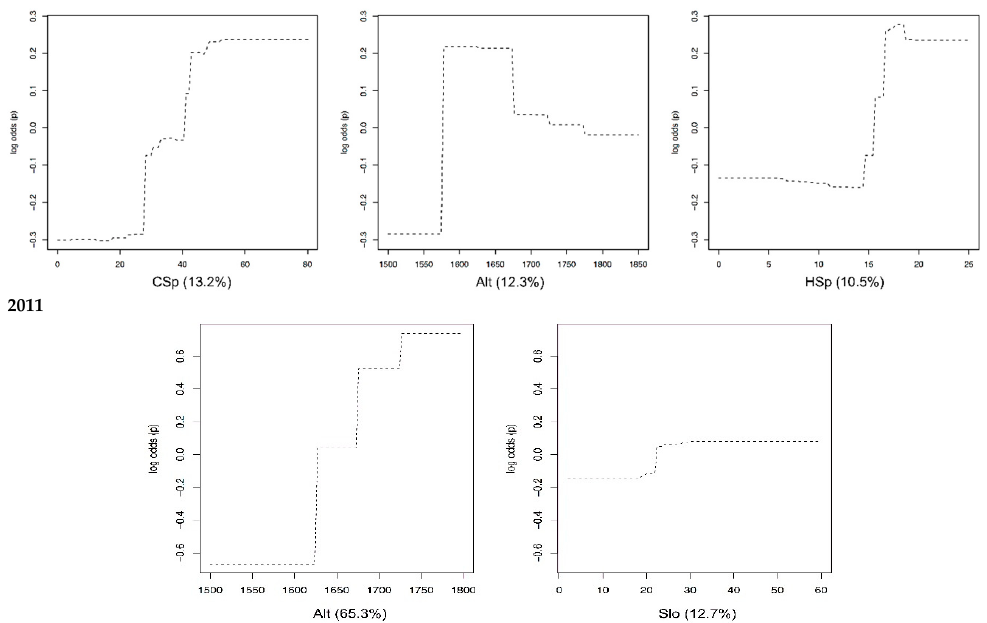
Figure 5. Relationship of the most influential variables (relative influence ≥ 10%) with capercaillie summer occurrence in 2001 and 2011, obtained by integrating out all other variables in a generalized boosted regression model. A logistic regression was used, and y-axes report the fitted values on log- odds scale (explanatory variables, with their codes, are reported in Table 2). Factors related to spruce were important for the presence of capercaillie. In 2001, capercaillie preferred forests where this tree species proportion exceeded 50% and had a mean height over 17–18